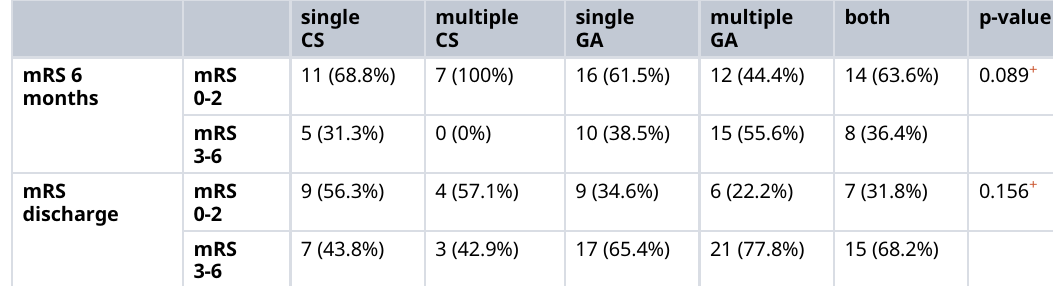
Table 2. Subgroup analysis of modified Rankin Scale (mRS) at 6 months and at